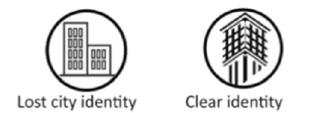
Figure 16. Foster a Clear Identity and Sense of Place.